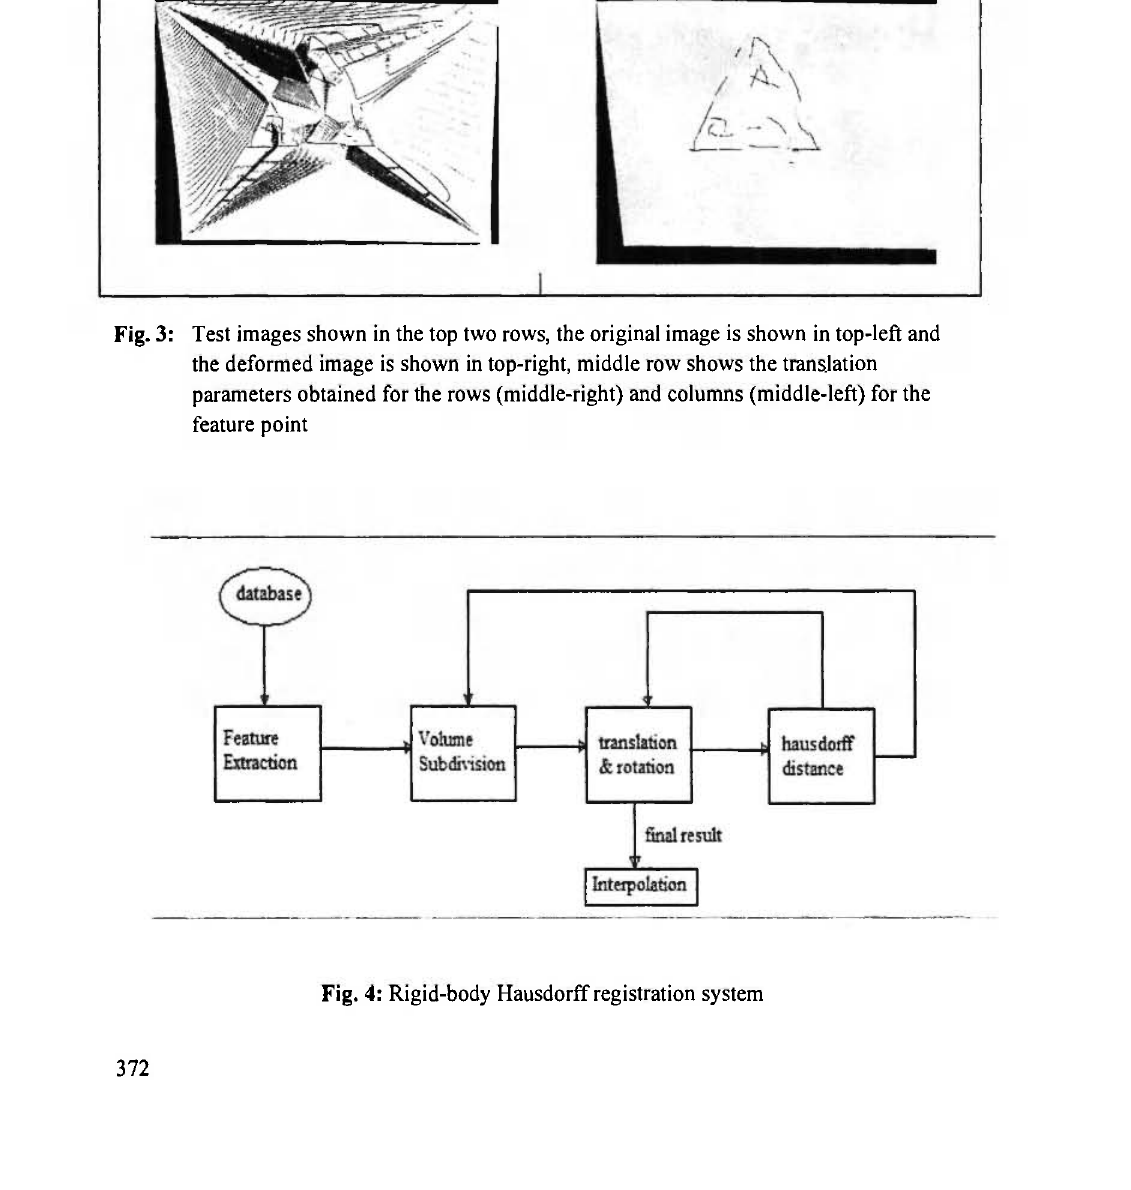
Fig. 4: Rigid-body Hausdorff registration